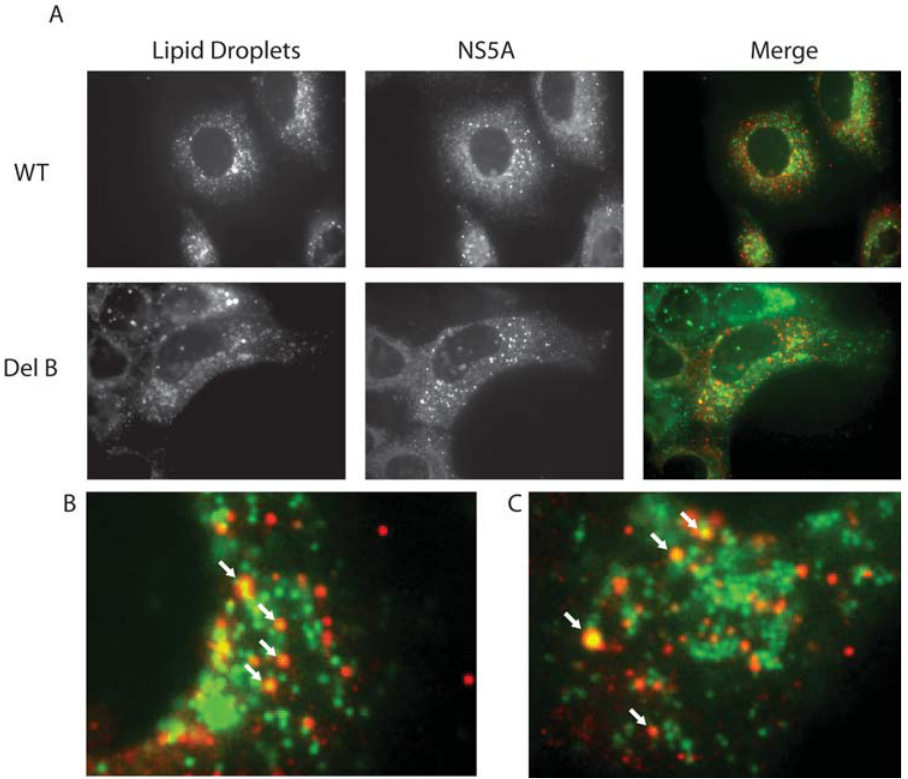
Figure 7. Deletion B does not alter the localization of NS5A to lipid droplets. A). Immunofluorescence microscopy of lipid droplets and NS5A from wild type J6/JFH-1 (top row) and a J6/JFH-1 virus bearing the deletion B mutation (bottom row). A merged color image of the lipid droplets and NS5A stained images is also shown (merge). B. A close up of a region of the wild type J6/JFH-1 merged image shown in A. White arrows indicate lipid droplets coated with NS5A. C. A close up of a region of the deletion B bearing J6/JFH-1 merged image shown in A. Arrows indicate lipid droplets coated with NS5A.